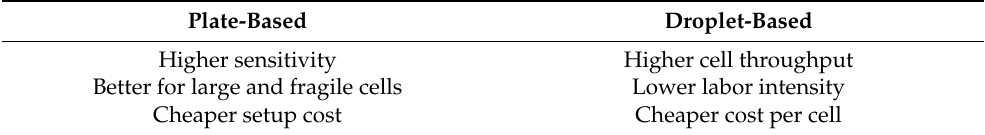
Table 1. Comparison between the two most frequently used scRNA-seq methods. Plate-Based Droplet-Based Higher sensitivity Higher cell throughput Better for large and fragile cells Lower labor intensity Cheaper setup cost Cheaper cost per